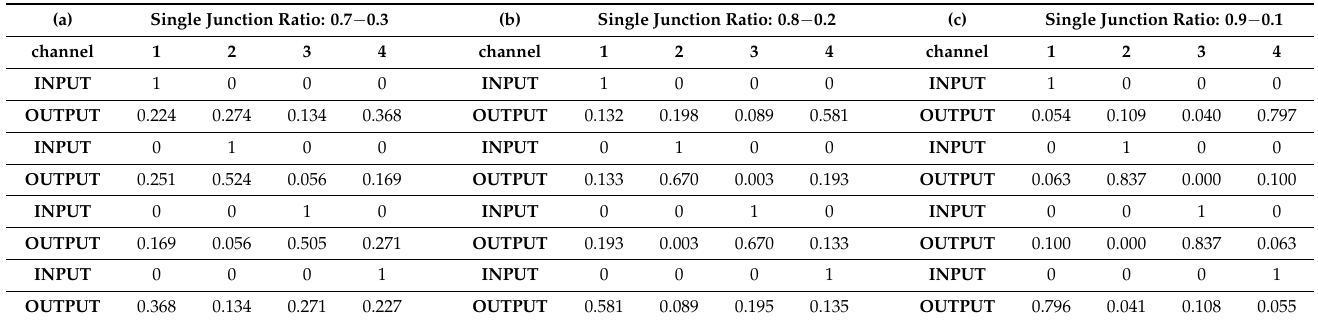
Table 2. Results of the simulation outputs of the mathematical model for 1-digit, 4-bit numbers